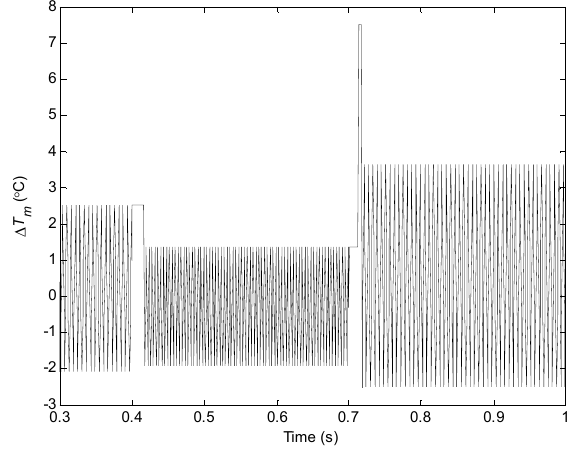
Figure 16. curves under decreasing S conditions. Figure 16. ∆ S D curves under decreasing S conditions. Figure 16. S  curves under decreasing S conditions. D